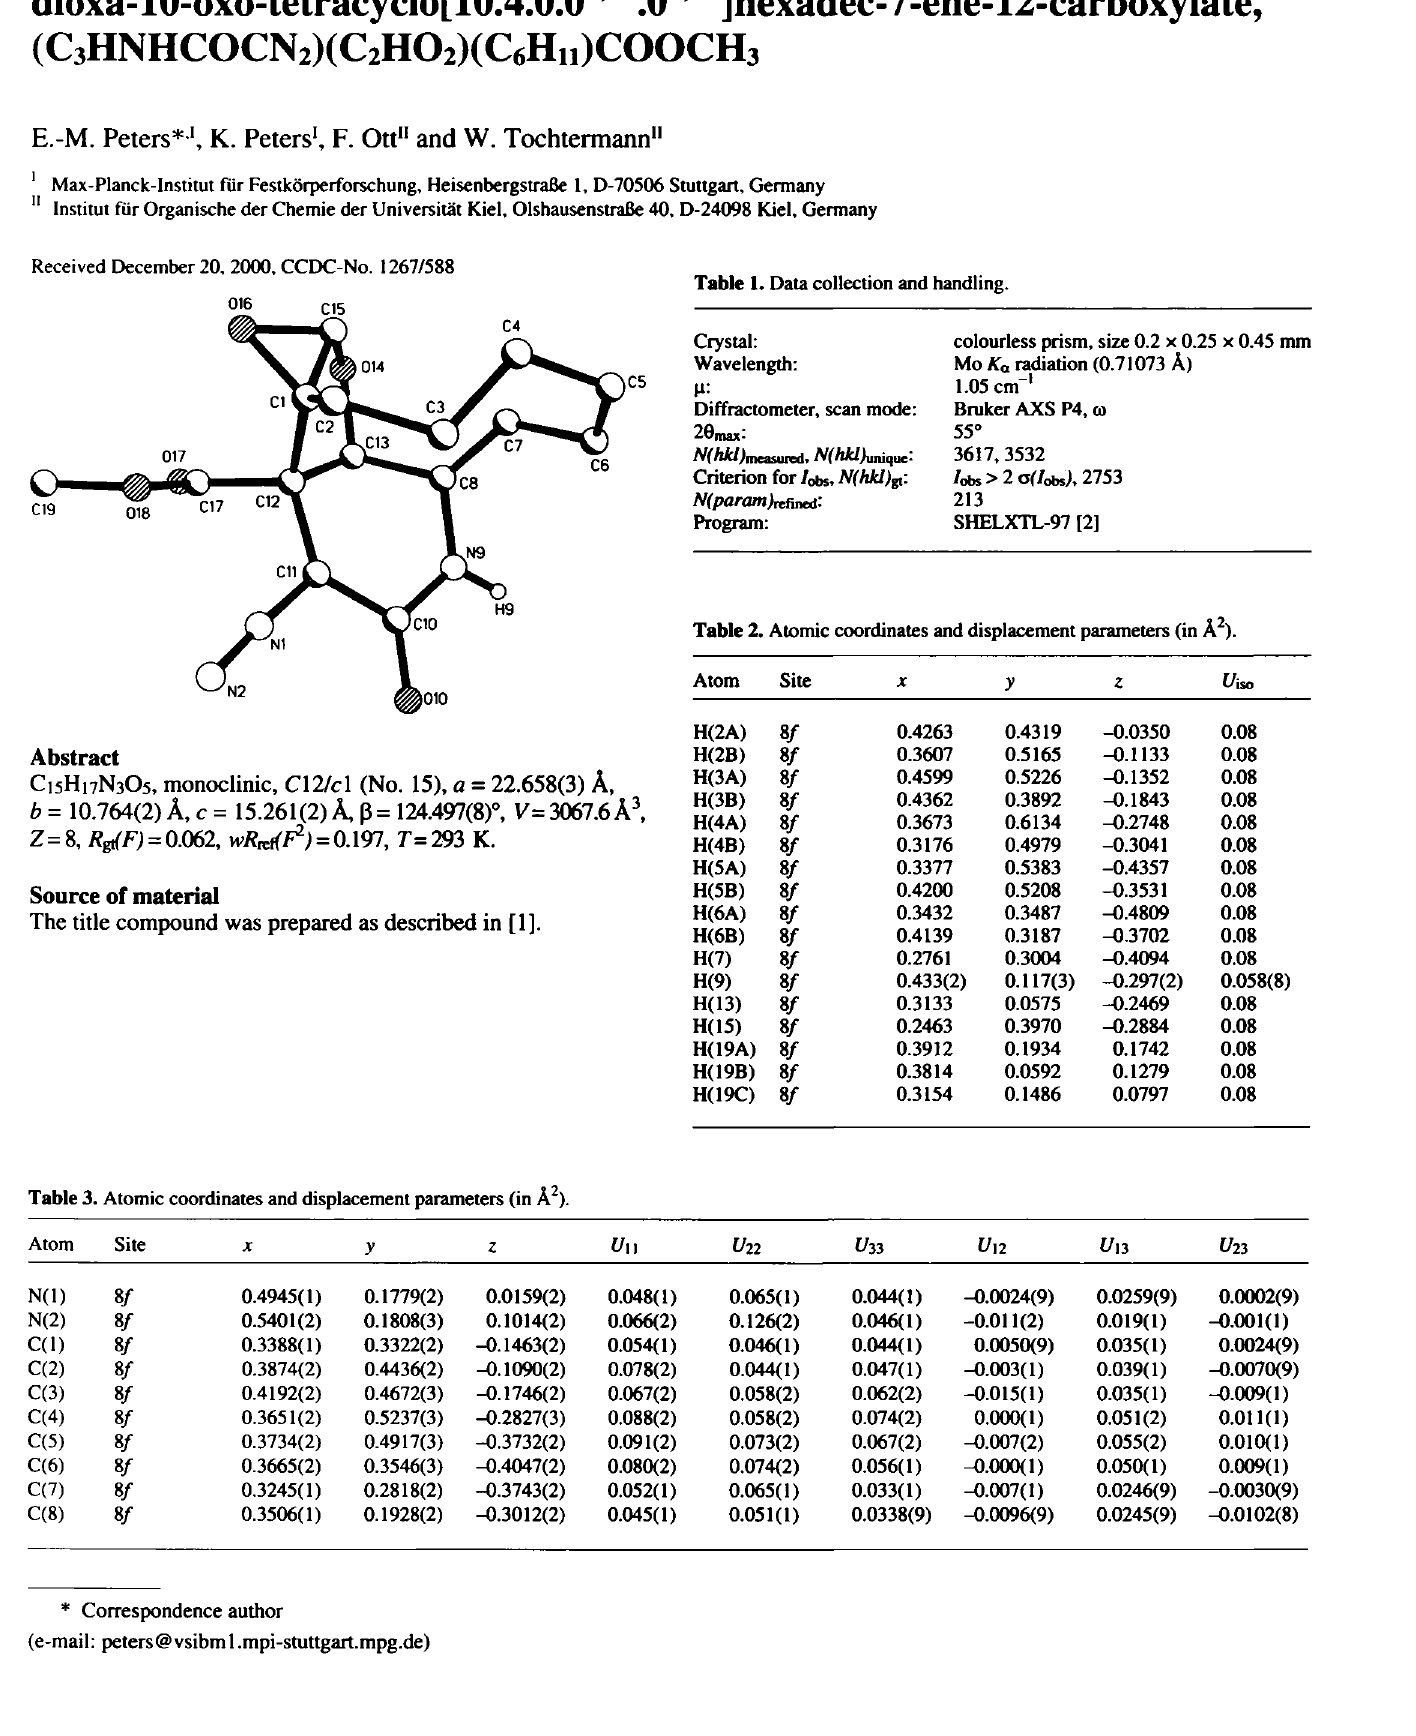
Table 1. Data collection and handling.